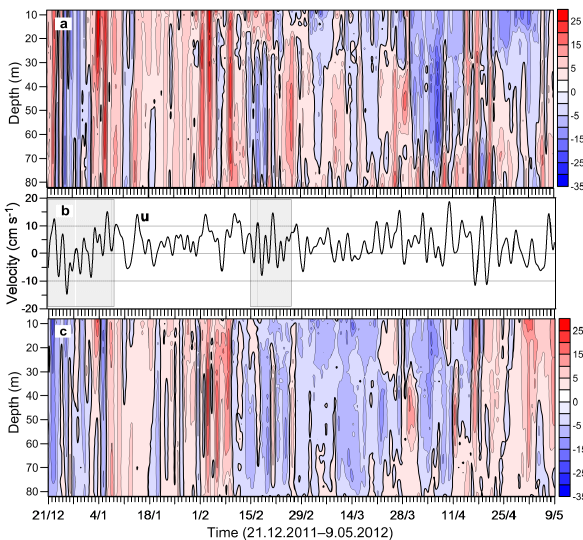
Figure 5. (a) Temporal course of the vertical distribution of low-pass filtered along-gulf axis current velocity component ( u ) and (c) cross-gulf axis current velocity component ( v ) in cm s –1 at the location of mooring station A9 from 21 December 2011 to 9 May 2012. Positive velocities (red) denote the inflow into the gulf or northward flow, and negative velocities (blue) denote the opposite, respectively. (b) Temporal course of along-gulf axis current velocity component ( u ) at a depth of 85 m. Shaded areas mark time intervals when estuarine circulation reversals prevailed.